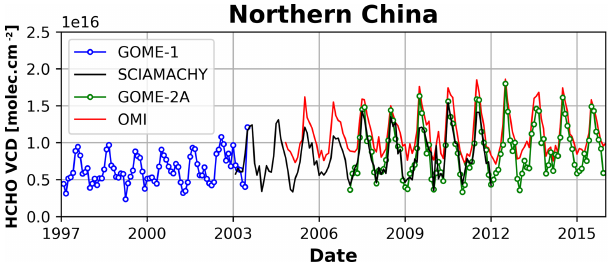
Figure 15. HCHO columns over northern China as observed with GOME (in blue), SCIAMACHY (in black), GOME-2 (in green), and OMI (in red) (De Smedt et al., 2008, 2010,